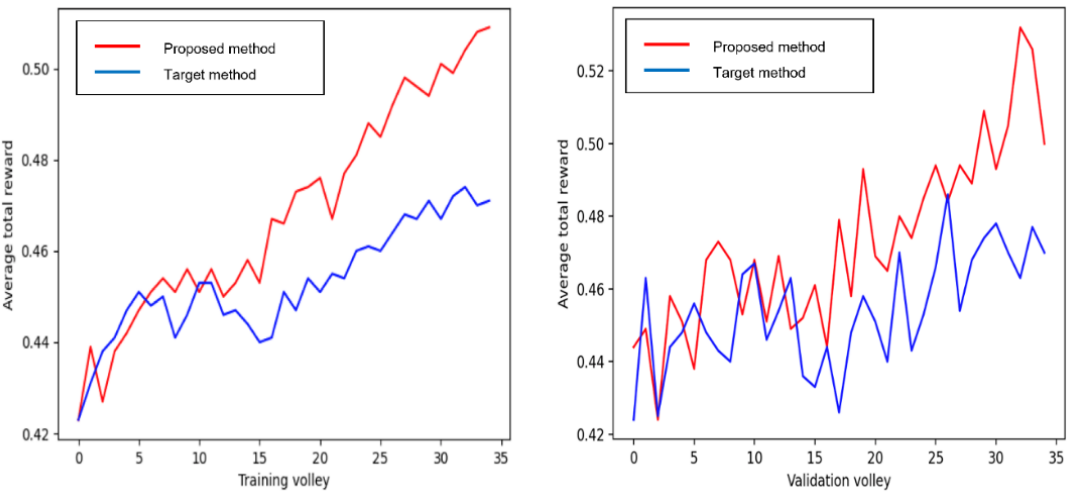
Figure 3. Comparative analysis of learning and verification between the proposed method and target method when there are 800 bits of random numbers.